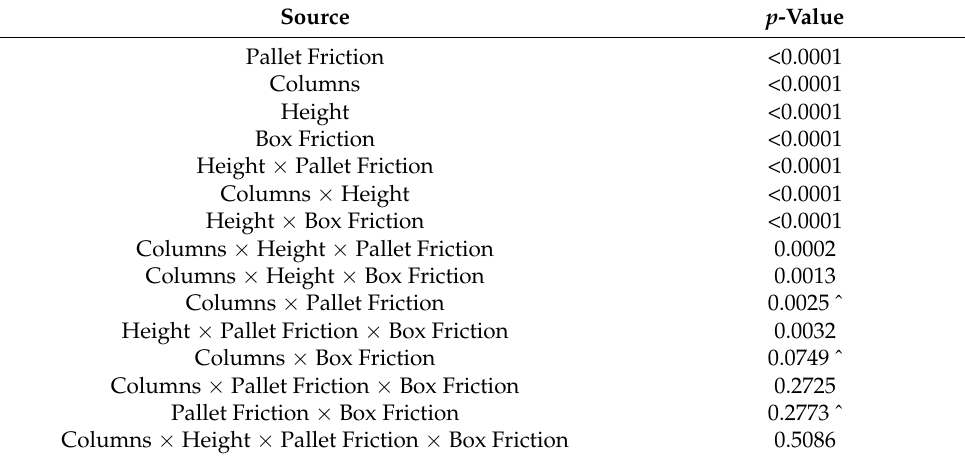
Table 6. Results of the 2 4 -full factorial design ANOVA ( p -values) for the significant effects of on the board deflection